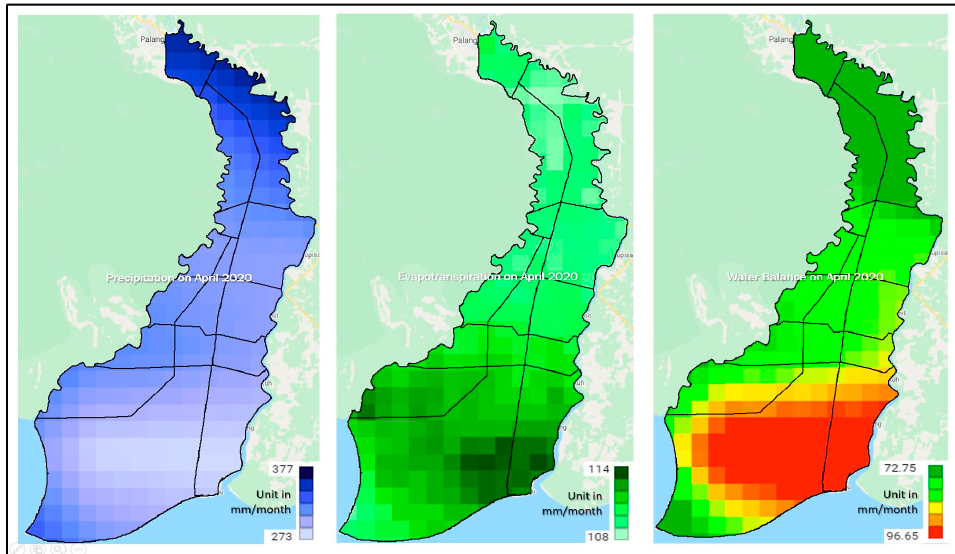
Figure 5. An example of spatial water balance calculations ( right ), evapotranspiration conditions ( center ), and distribution of rainfall values ( left ) in the Kahayan–Sebangau PHU area in April 2020. (data source: TerraClimate using Google Earth Engine; processed by the authors).